Question: Condense the content of this figure into a single sentence.
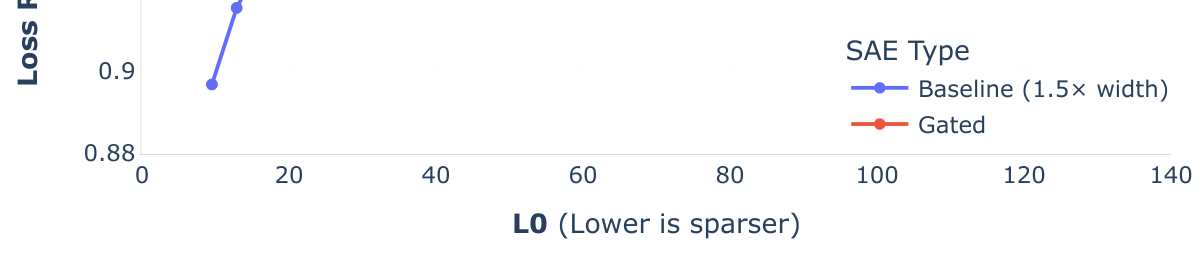
Answer: | Gated SAEs offer better reconstruction fidelity (as measured by loss recovered) at any given level of feature sparsity (as measured by L0). This plot compares Gated and baseline SAEs trained on GELU-1L neuron activations; see Appendix B for comparisons on Pythia-2.8B and Gemma-7B.